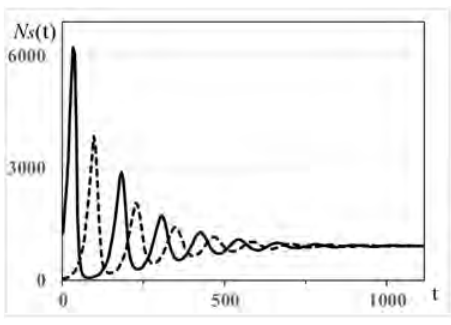
Fig. 10. Graphs of N P ( t ) for non-oscillating dynamics for 3 different initial values ϕ ( a ) .